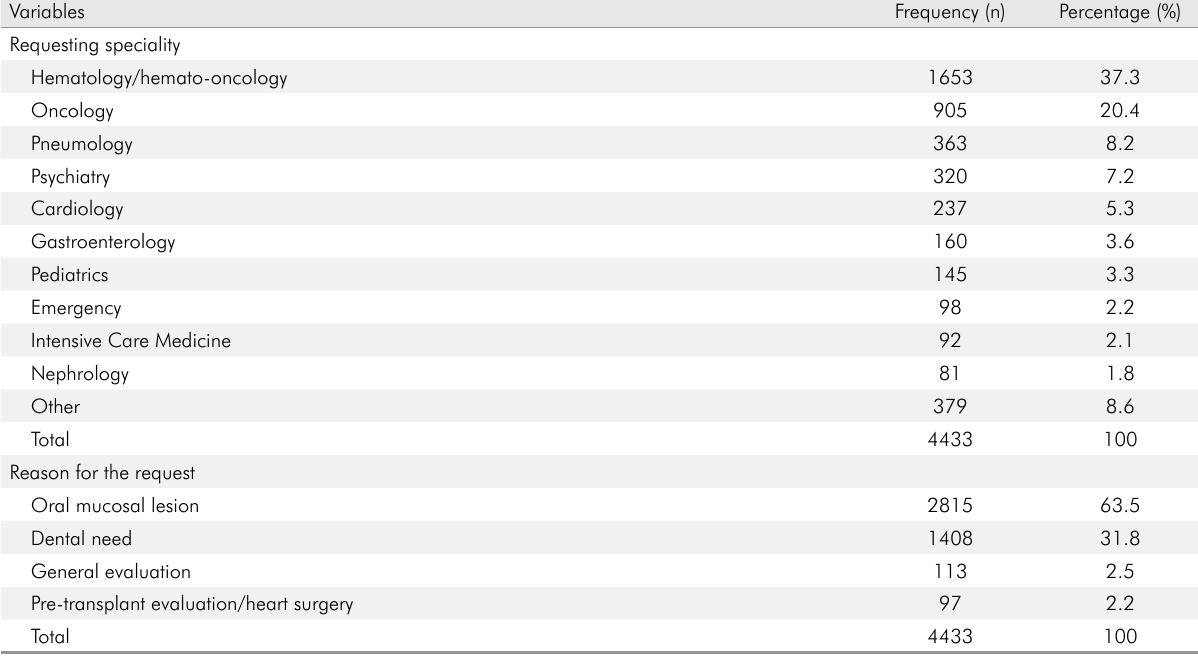
Table 2. Simple (n) and relative (%) frequencies of data related to referrals.